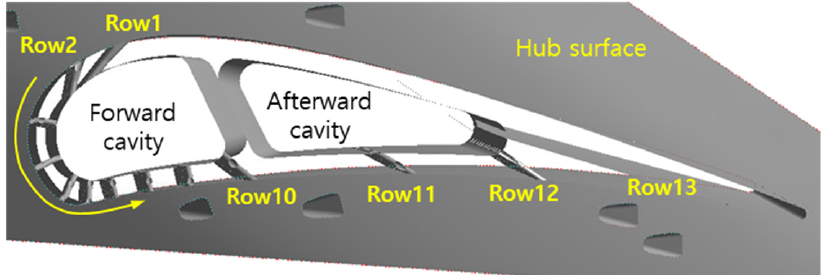
Figure 3. Cooling hole array (reprinted with permission from [16]; copyright 2021 Korean Society for Fluid Machinery).